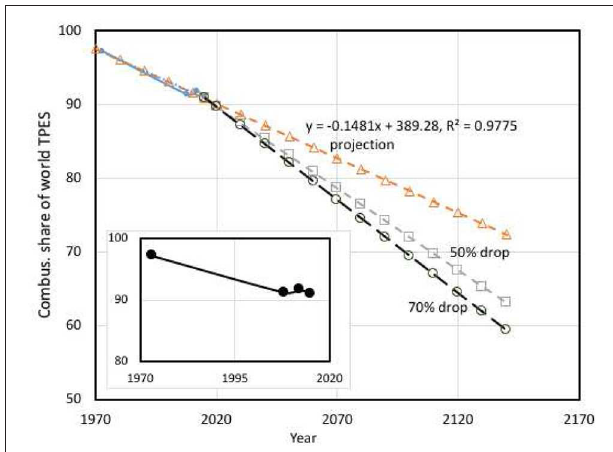
FIGURE 1 | The contribution of combustion to world TPES and its future